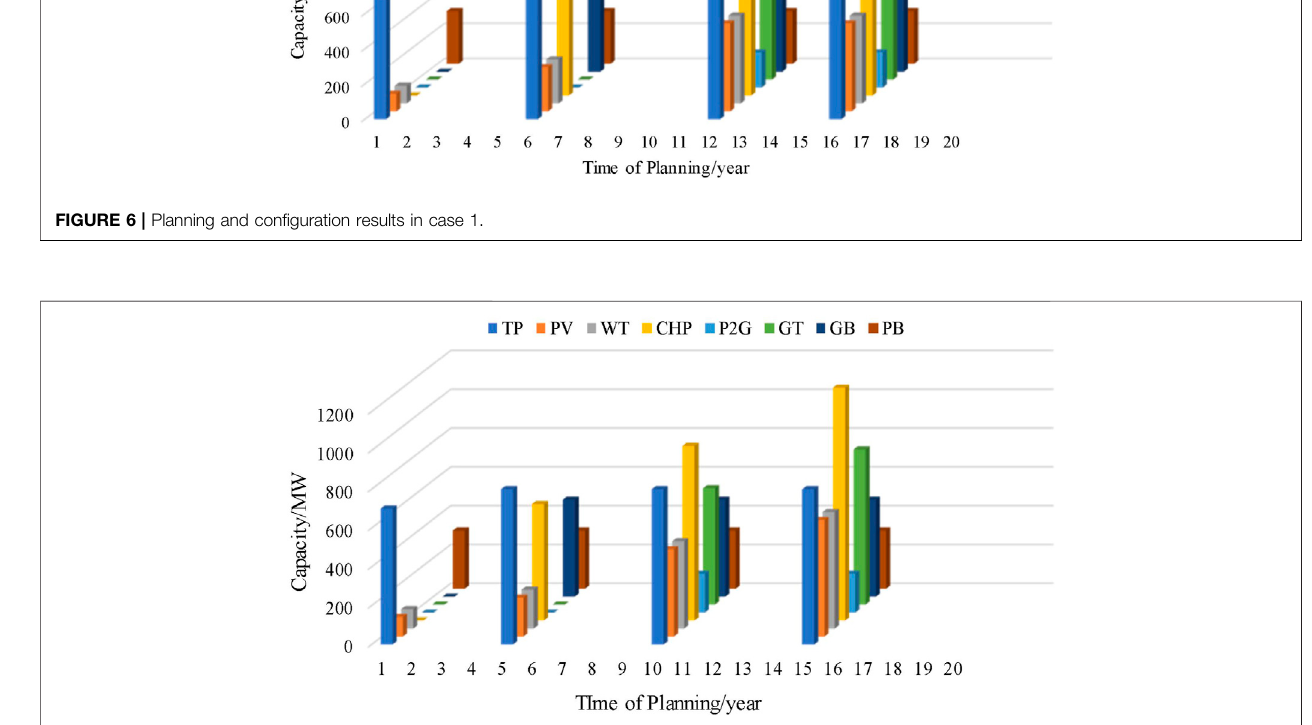
FIGURE 7 | Planning and configuration results of case